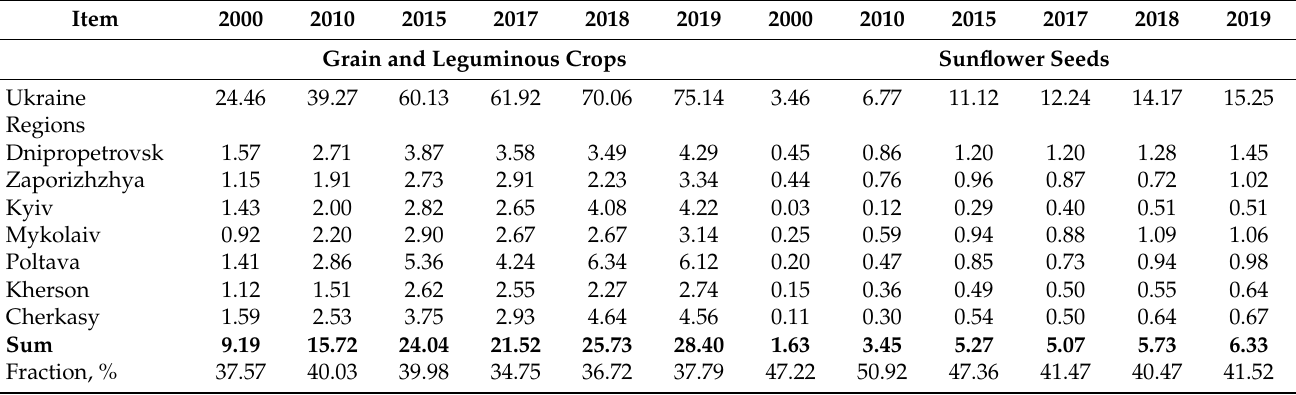
Table 1. Modal split of agricultural products, million